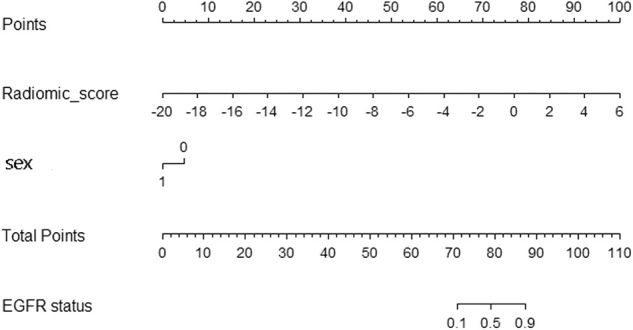
Radiomic nomogram. In the training cohort, the nomogram incorporated the radiomic signature and sex.